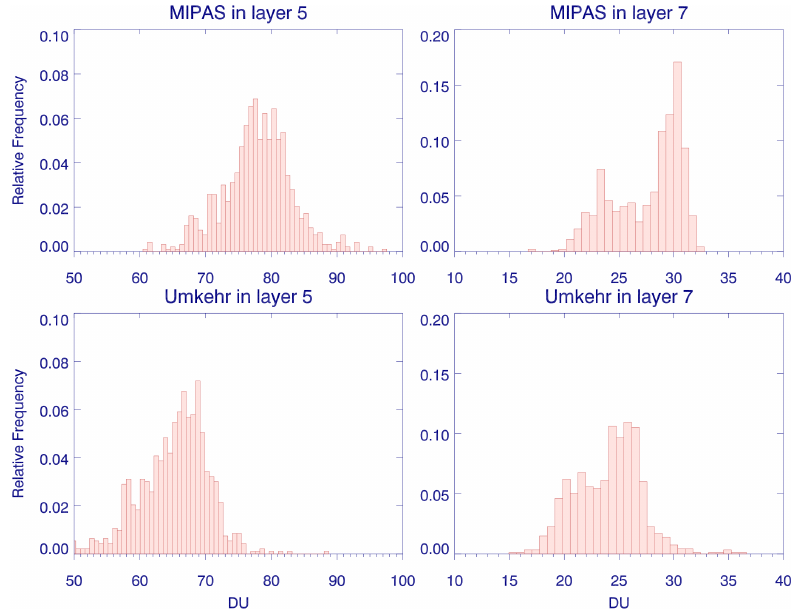
Figure 11. Distribution of MIPAS (upper panels) and Umkehr (lower panels) O 3 values in layer 5 (left panels) and layer 7 (right panels) at Boulder station, 40 ◦ N, in 2005–2012. Layer 5 corresponds approximatively to 32–16hPa and layer 7 approximatively to 8–4hPa.